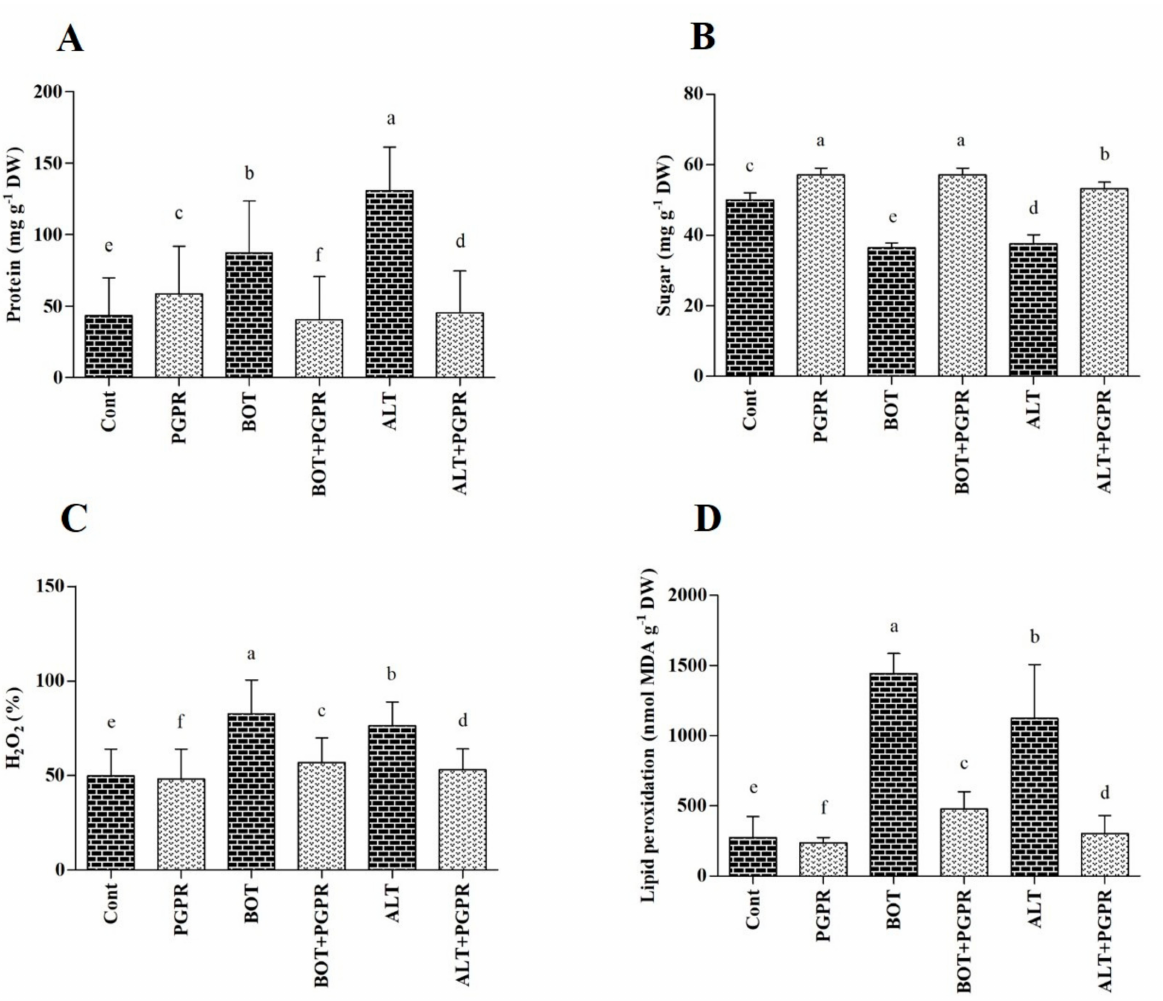
Figure 7. ( A ) protein, ( B ) sugar, ( C ) hydrogen peroxide, and ( D ) malondialdehyde contents in the leaves of peppers grown under normal and stress conditions and treated with plant growth-promoting rhizobacteria (PGPR) after eight days. Treatment: Cont (control), PGPR ( Bacillus amyloliquefaciens ), BOT ( Botrytis pelargonii ), PGPR + BOT ( Bacillus amyloliquefaciens + Botrytis pelargonii ), ALT ( Alternaria alternata ), PGPR + ALT ( Bacillus amyloliquefaciens + Alternaria alternata ). Values show the means ± standard error ( n = 3) and significant differences are indicated at p < 0.05 in accordance with the least significant difference test. Bars with different letters are significantly different from each